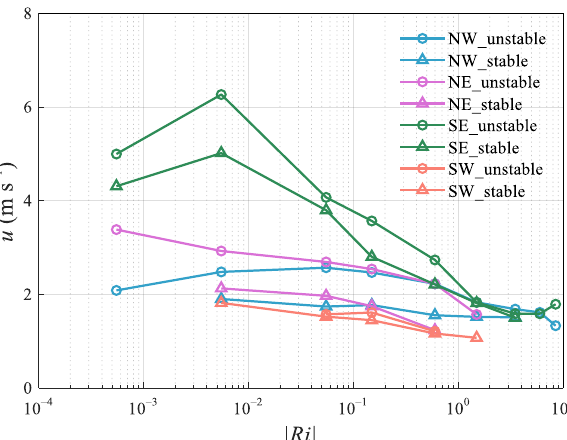
Figure 5. The dependence of the longitudinal wind speed, u , on the stratification stability Ri . Each point in the figure represents the average value of u in the corresponding Ri interval. The hollow circles and the hollow triangles represent unstable and stable conditions respectively. Only data with a sample size greater than 15 in the corresponding Ri range are shown.